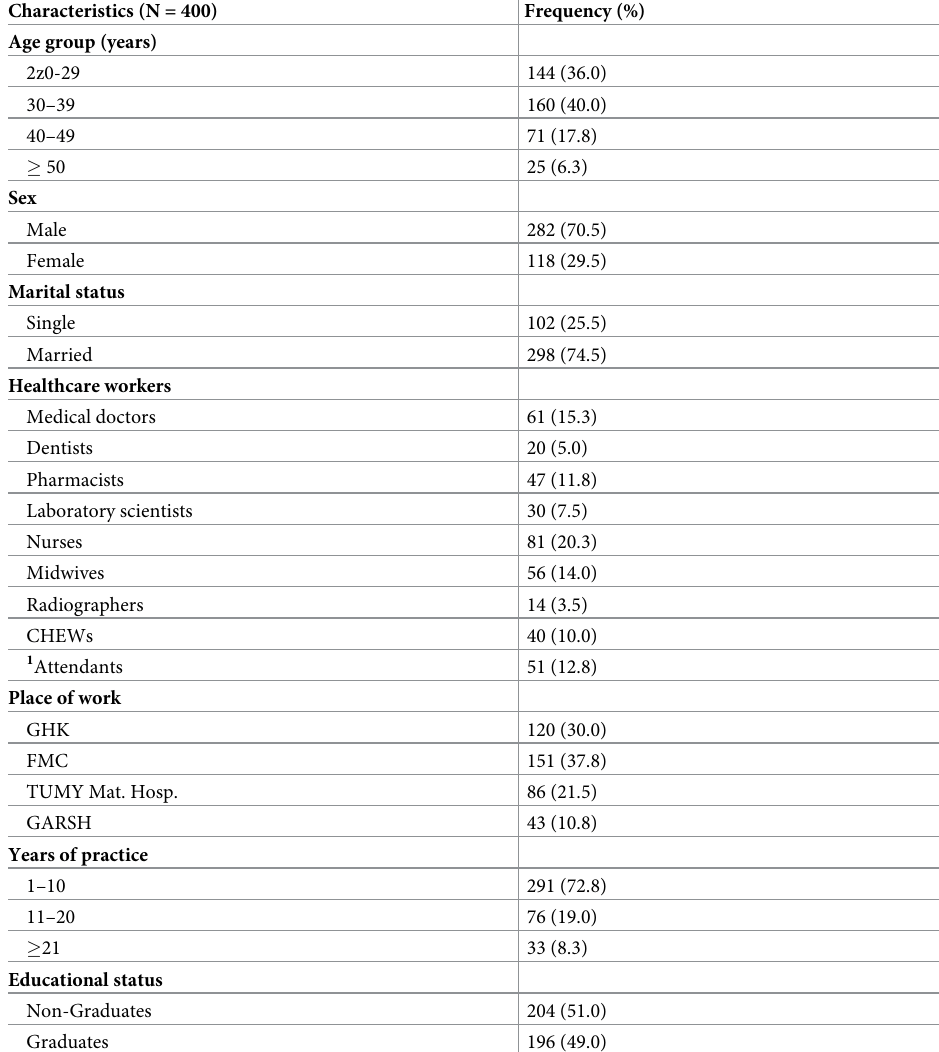
Table 1. Demographic profiles of the study